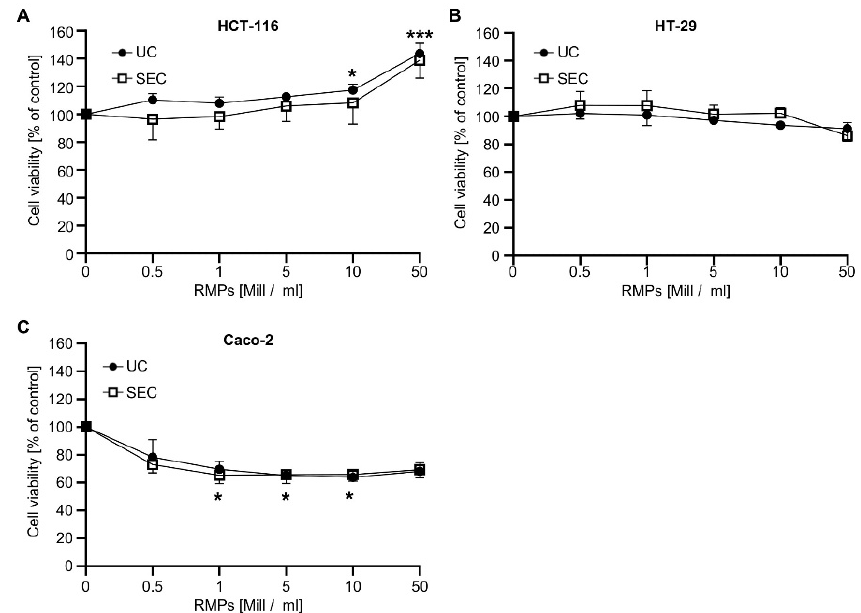
Figure 2. Influence of red-blood cell-derived microparticles on the viability of different colon carci- noma cells.( A ) HCT-116, ( B ) HT-29 and ( C ) Caco-2 cells were incubated with increasing concentrations of RMPs (0.5–50 × 10 6 particles/mL) or vehicle control (phosphate buffered saline = PBS). After 48 h, cell viability was assessed by the WST-1 assay. Data represents mean + SD versus vehicle control (100%). At least three independent experiments (each measured in triplicate) were performed for RMPs isolated via ultracentrifugation (UC; n = 5) or size exclusion chromatography (SEC; n = 3 for HCT-116, n = 4 for HT-29 and Caco-2). Statistical analysis: Kruskal–Wallis test followed by Dunn’s multiple comparisons test compared to vehicle control (* p ≤ 0.05; *** p ≤ 0.001). Incubation with RMPs isolated via SEC did not reach significance, although the cell viability of HCT-116 cells increased to a similar extent when treated with 10 × 10 6 RMPs/mL (108.2 ± 12.4%) and 50 × 10 6 RMPs/mL (138.8 ± 10.4%). These results indicate that the effect of RMPs on tumor cell growth does not seem to be impacted by the isolation method used. To exclude cell-specific effects, we analyzed the effect of RMP on the viabil- ity of two further colon carcinoma cell lines, HT-29 and Caco-2. As can be seen in Figure